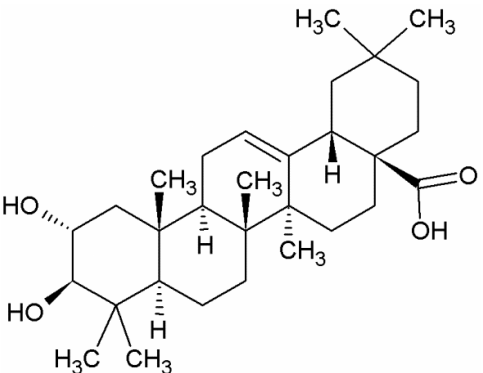
Figure 1. Chemical structure of maslinic